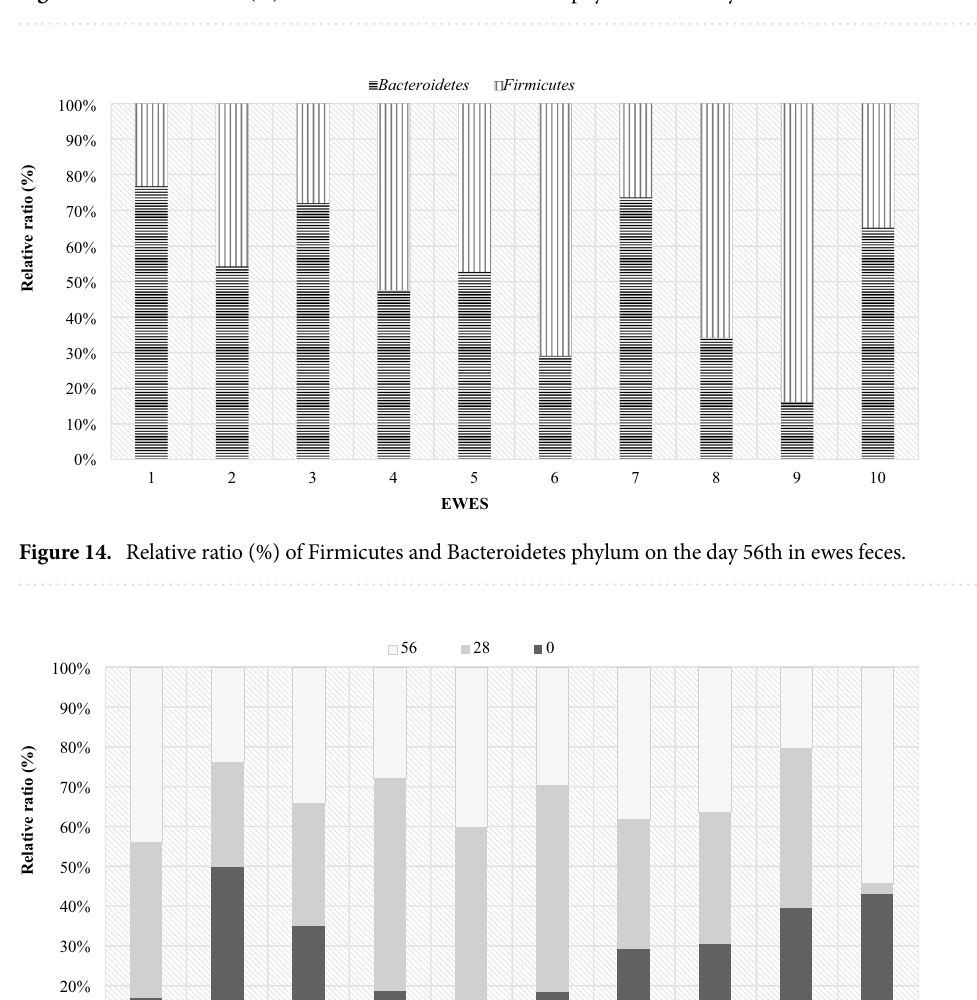
Figure 13. Relative ratio (%) of Firmicutes and Bacteroidetes phylum on the day 28th in ewes feces.